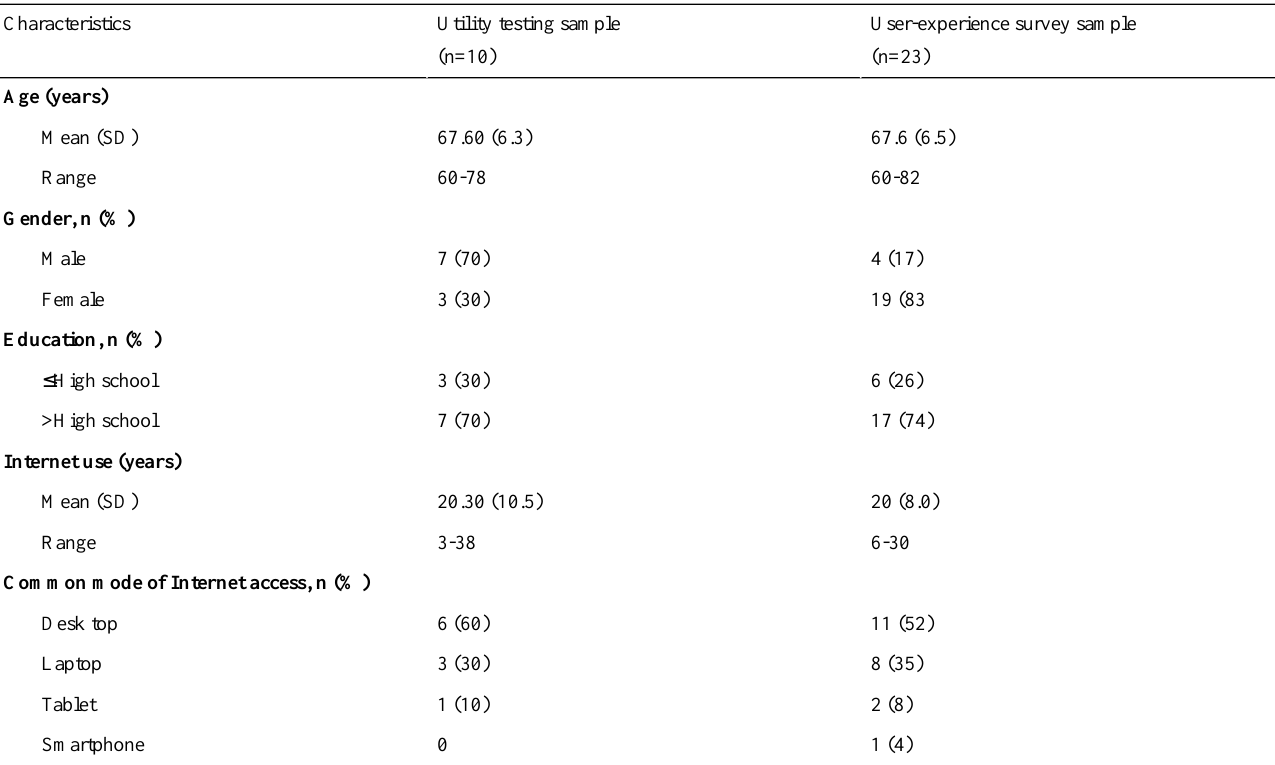
Table 1. Characteristics of participants in usability testing and user-experience survey of